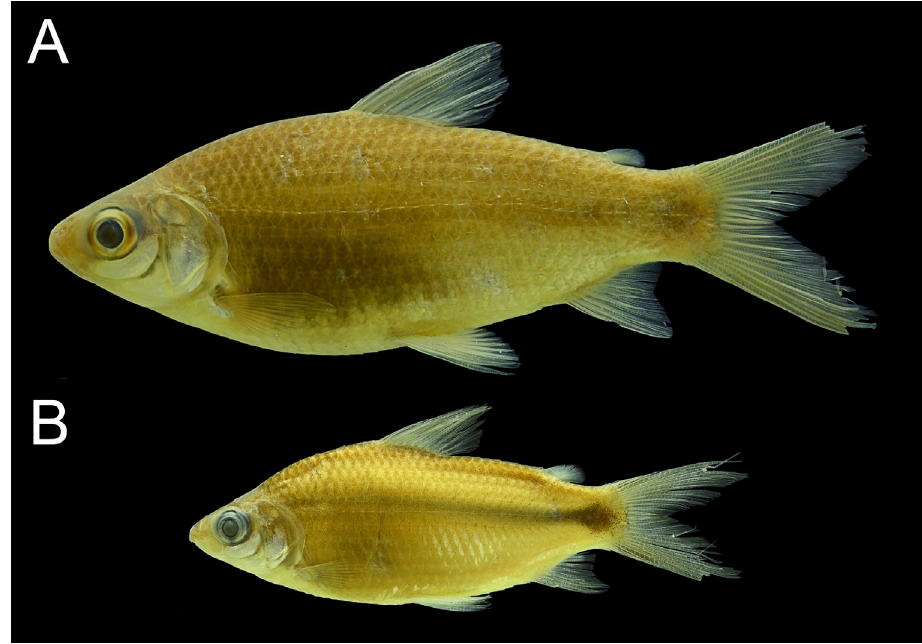
FIGURE 1 | Lateral view of Cyphocharax tamuya . A. MZUSP 125833, holotype, 106.8 mm SL, Paraibuna River, Paraíba do Sul River basin, São Paulo, Brazil; B. MZUSP 108117, paratype, 69.7 mm SL, Paraitinga River, Paraíba do Sul River basin, São Paulo,